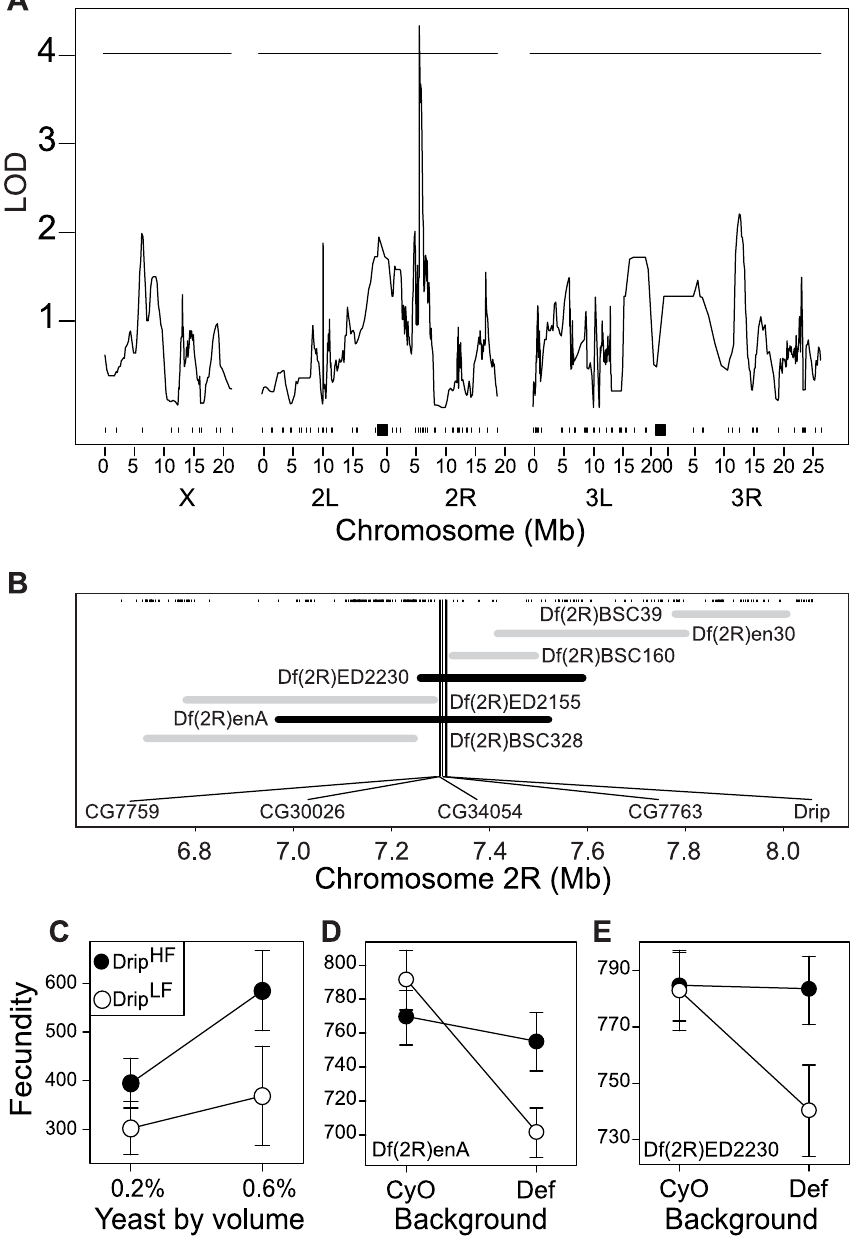
Figure 1. QTL and fine-scale mapping of female fecundity localizes to 5 positional candidate genes. (A) QTL scan results for fecundity. The x -axis represents position along the three major D. melanogaster chromosomes in megabases (Mb). Tick marks represent location of polymorphic markers used for QTL mapping and black squares represent the approximate location of the centromeres. The y -axis represents the strength of association between a particular region and fecundity. The horizontal line represents the 95% permutation threshold. (B) Deficiency map of the QTL region on 2R. The x-axis represents position along chromosome 2R in megabases (Mb). Tick marks represent location of known genes and the horizontal bars represent the location (either molecularly defined or approximate) of deficiency break points. Grey bars represent deficiencies that complemented the RIL alleles, black bars represent deficiencies that failed to complement the RIL alleles. The five named genes are those genes identified by quantitative complementation as candidates genes affecting fecundity. (C) Estimated effect of the two RIL alleles at the QTL identified on chromosome 2R. Black and white circles represent high and low fecundity alleles, respectively. The x -axis represents larval rearing condition. The y - axis represents estimated fecundity. Error bars represent 95% CI calculated from amongst line variance. (D–E) Results from quantitative complementation tests with the two deficiencies that failed to complement the two alleles in the mapping population. The x -axis of each inset represents the tester chromosome (either ‘‘wild-type’’- CyO, or deficiency – Def). Black vs. white circles represent the high and low fecundity RIL alleles, respectively. The y -axis of each inset represents estimated fecundity (see Materials and methods for more details). Error bars represent 95% CI based on non-parametric bootstrap resampling (5000 replicates), conditional on fly.